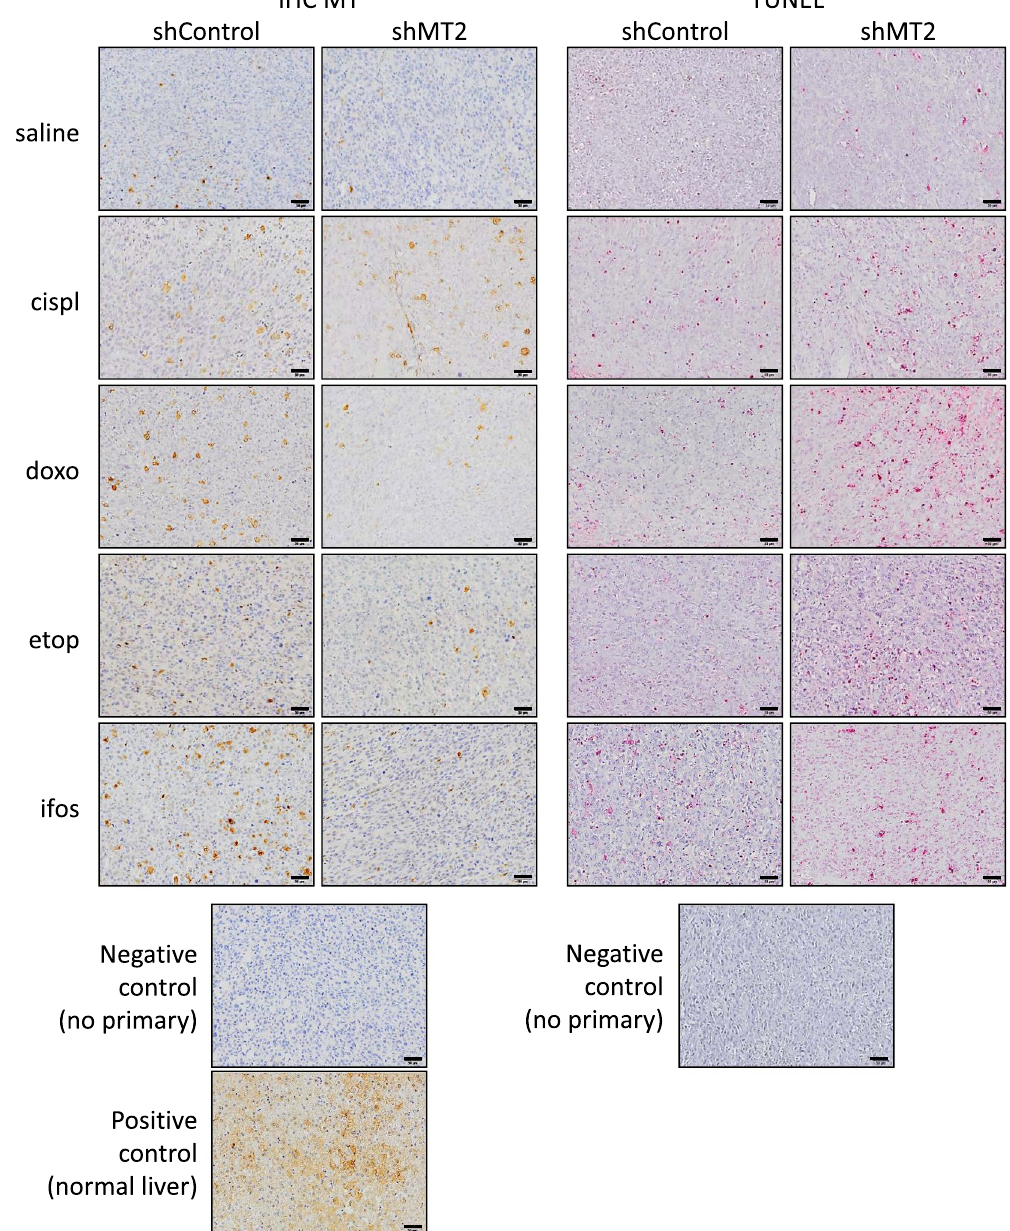
Figure 5. Silencing of MT2 improves chemotherapy cytotoxic effects in a preclinical model. Representative image showing immune-histochemical (IHC) staining for MTs in primary tumour FFPE sections (left panel). A negative control of the MTs stain by omitting the primary antibody, and a positive control of MTs stain on normal liver sample were included. The scale bars represent 50 μ m (right panel). Representative images illustrating TUNEL staining in primary tumour FFPE sections. A negative control of TUNEL stain by omitting the primary antibody was